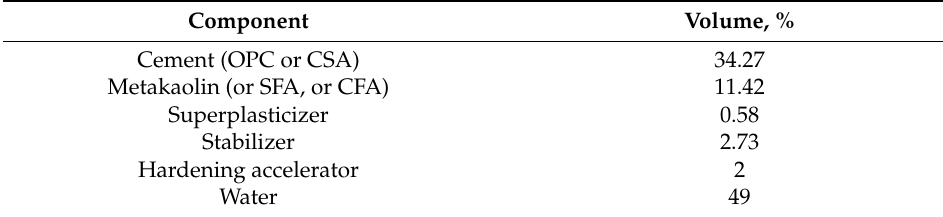
Table 2. Cement paste composition.